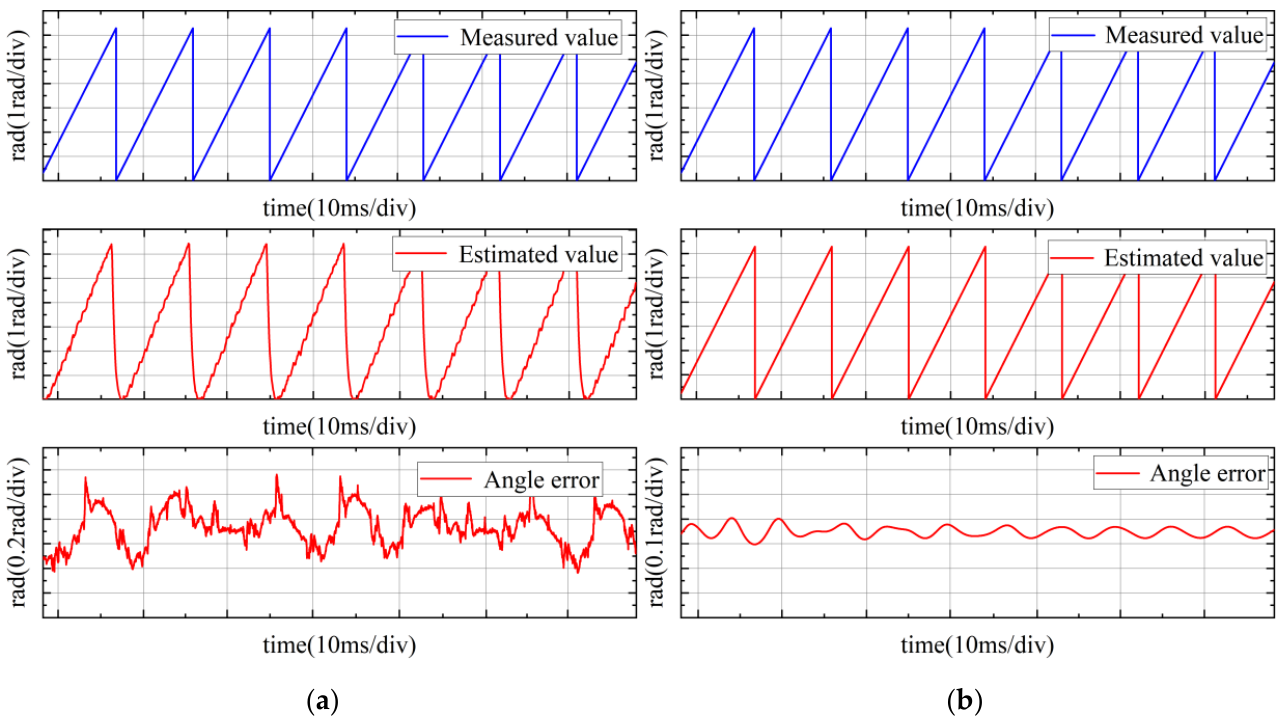
Figure 19. Rotor position experimental results: ( a ) traditional SMO rotor actual position, estimated position and position error; ( b ) improved SMO rotor actual position, estimated position, and position error.